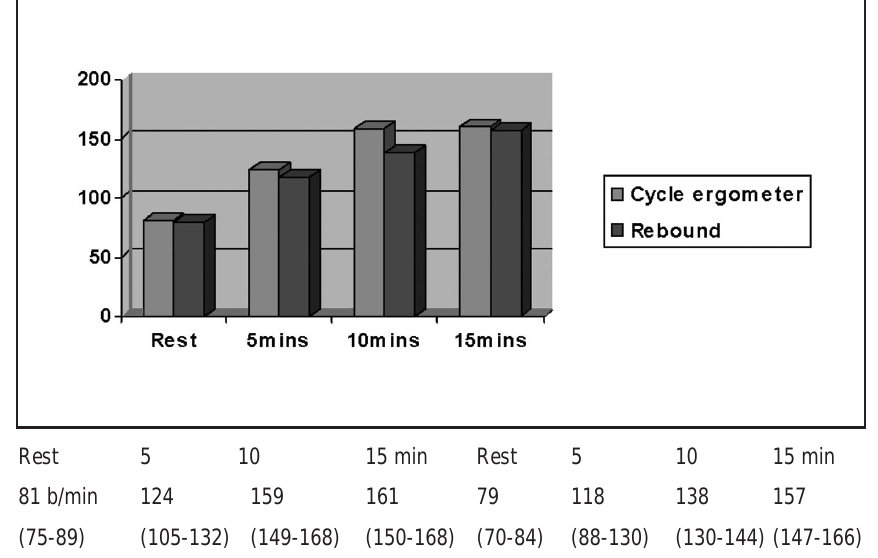
Figure 1: Heart rate (beats/min)